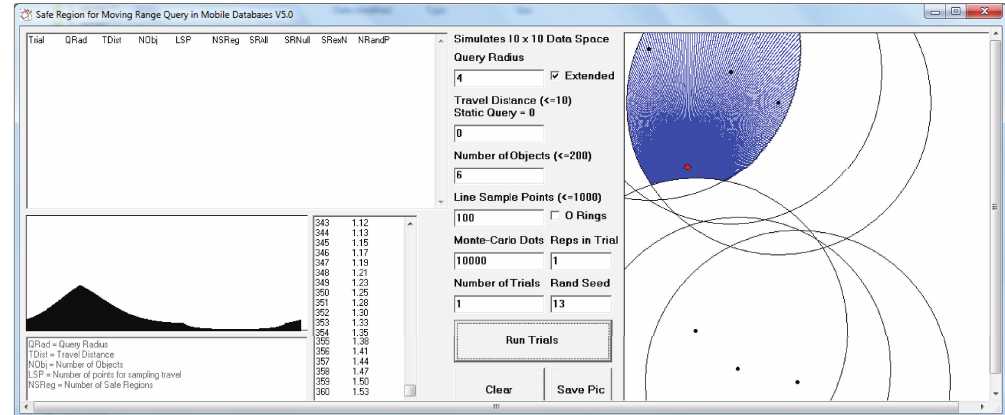
Figure 9: Distance that a query travels before leaving its safe region.